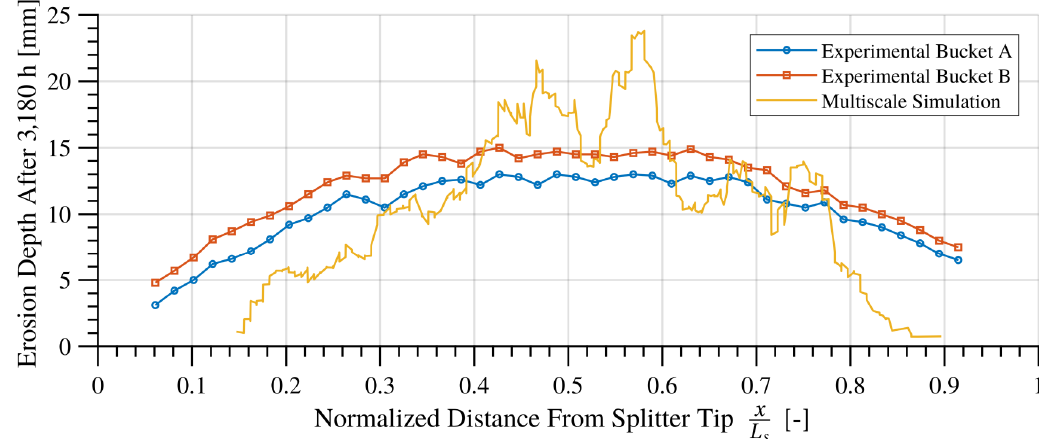
Figure 6. Eroded depth distribution on the bucket splitter after 3180 h of operation, including the experimental data of Rai et al.